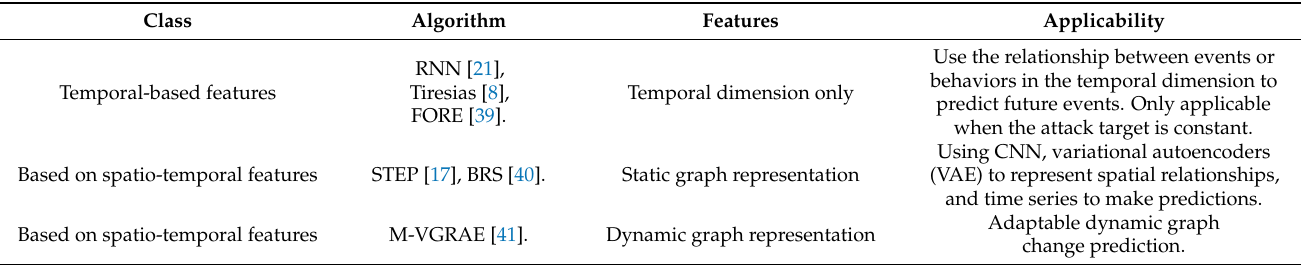
Table 2. Comparison of network event prediction